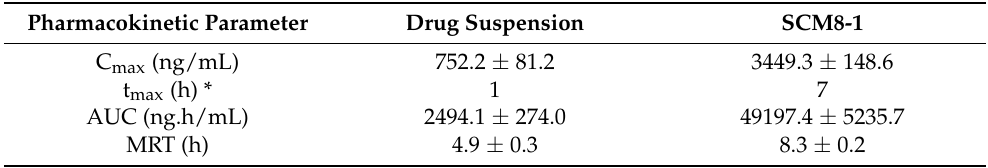
Table 2. Pharmacokinetic parameters of terconazole following the ocular administration of drug suspension and the selected formulation. SCM8-1 to the rabbits’